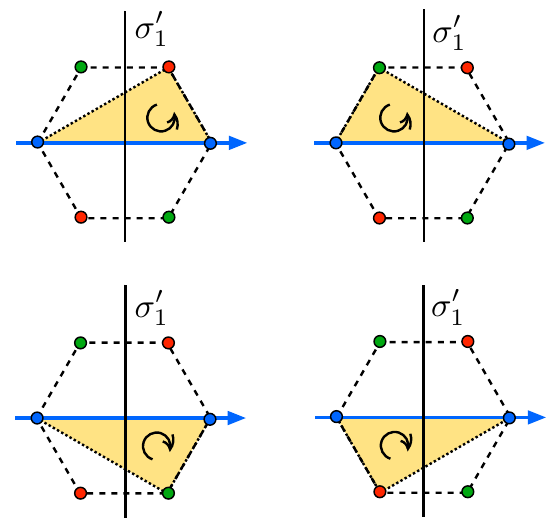
Figure 2: Scalar spin chirality terms in Eq. (3) that involve a pair of spins on the same chain (here, with q = 1 direction). These chiralities are staggered under π/ 3 lattice rotation R . This pattern breaks the symmetry under mirror reflection σ (cid:48) perpendicular to the chain, but 1 it preserves reflection σ along the 1